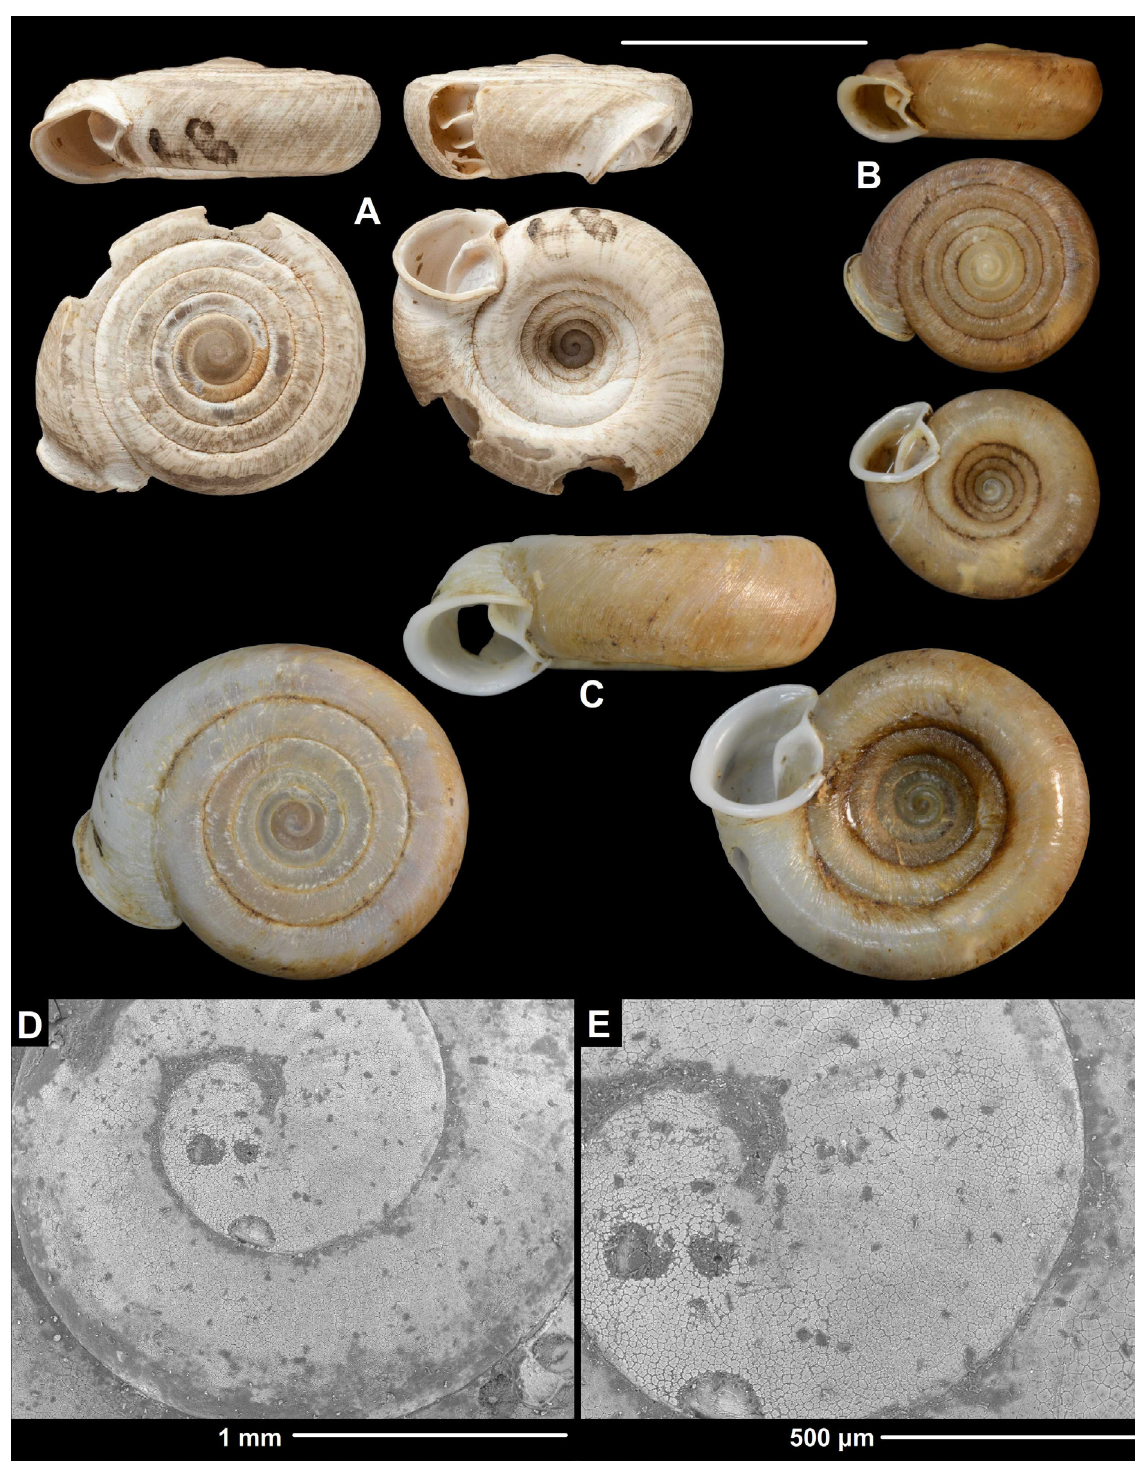
Fig. 23. Shells and protoconch of species of Chersaecia Gude, 1899. A . C. perrierae (Gude, 1898), holotype (NHMUK 1922.8.29.40). B . C. perrierae , loc. 20091019A, Specimen 2 (coll. PGB). C–E . C. refuga (Gould, 1846), lectotype (MCZ 169335). Scale bar: A–C = 10 mm. Images: B. Páll-Gergely (B–E) and H. Taylor